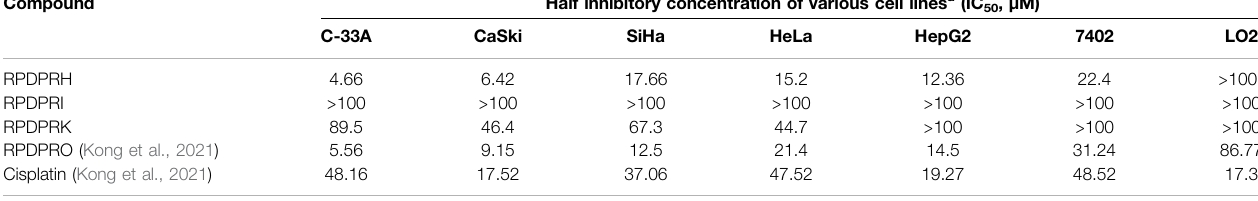
TABLE 1 | Anti-cancer activities in vitro of synthesized four compounds. Compound Half inhibitory concentration of various cell lines a (IC 50 , μ M) C-33A CaSki